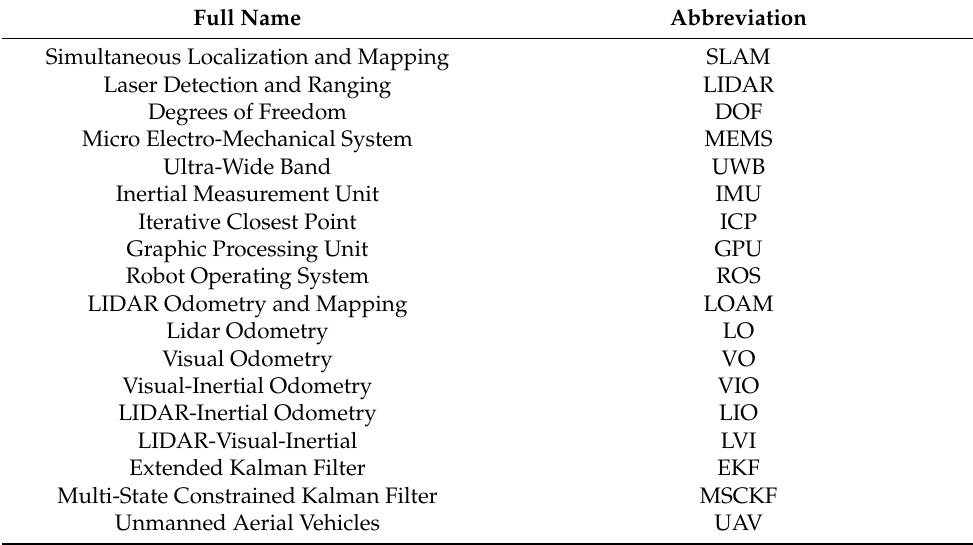
Table 1. Abbreviations for terms.